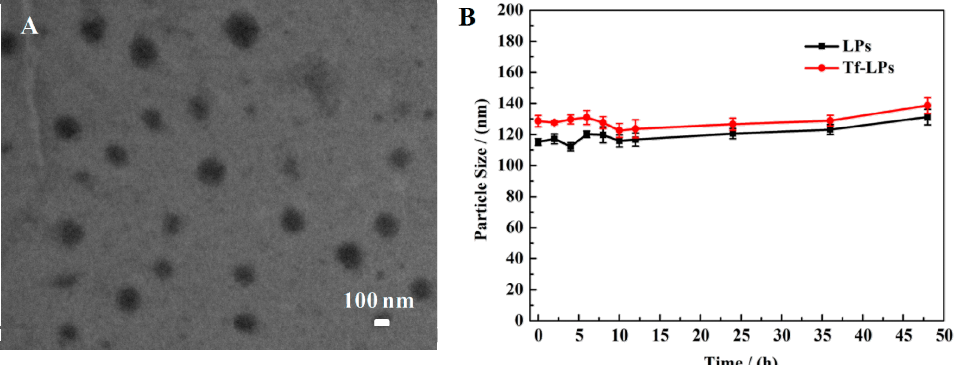
Figure 2. TEM image of Tf-LPs and their colloidal stability in serum ( n = 3). ( A ) TEM image (×50,000), ( B ) the stability of Tf-LPs in 10% of serum. Tf-LPs possessed spherical shape and uniform size, the diameter was ~90 nm. The stability of Tf-LPs in 10.0% of FBS was measured by DLS, indicating good stability in serum. Abbreviations: LPs, DOX-loaded liposomes; Tf-LPs, DOX-loaded Tf-liposomes.